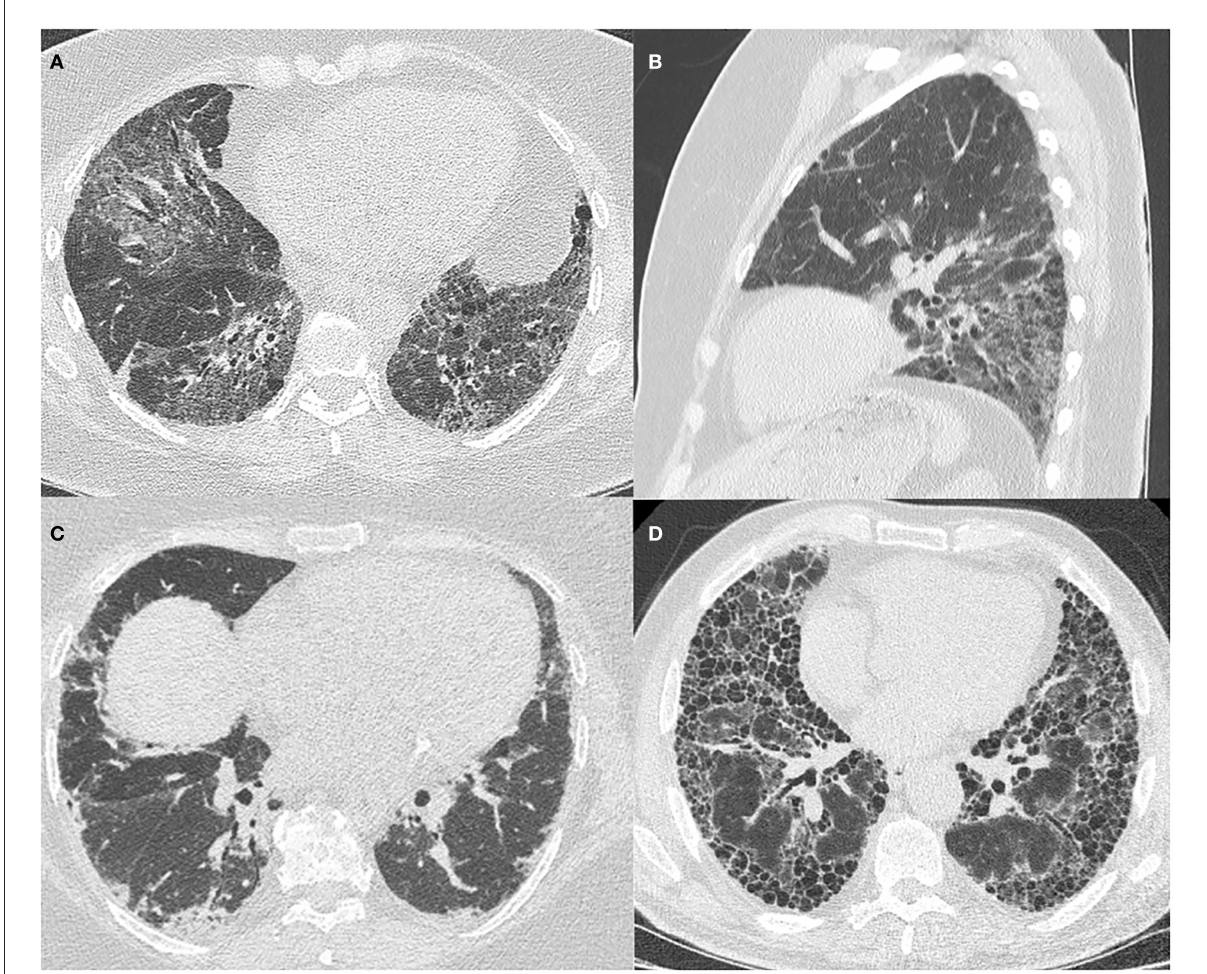
FIGURE1 HRCT images of ILD patterns seen in ASyS. All patients are positive for anti-Jo1 antibody and have an MDT diagnosis of ASyS. (A) Axial view of fibrotic NSIP demonstrating patchy ground glass opacification with reticulation and traction airway dilatation; (B) Sagittal view of fibrotic NSIP demonstrating the lower zone predominance in the same patient; (C) Axial view of organizing pneumonitis with patchy, peripheral basal predominant consolidation; (D) Axial view showing UIP pattern with subpleural basal predominant reticulation and extensive honeycombing